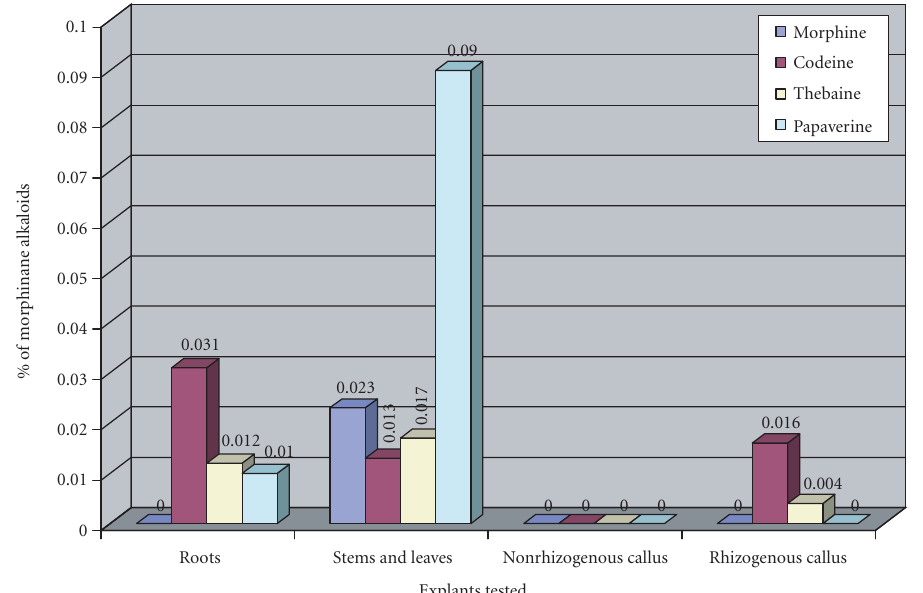
Figure 6: Concentrations of morphinane alkaloids (mg/100mg of dryed material) obtained in function of explants tested, in Papaver soniferum album